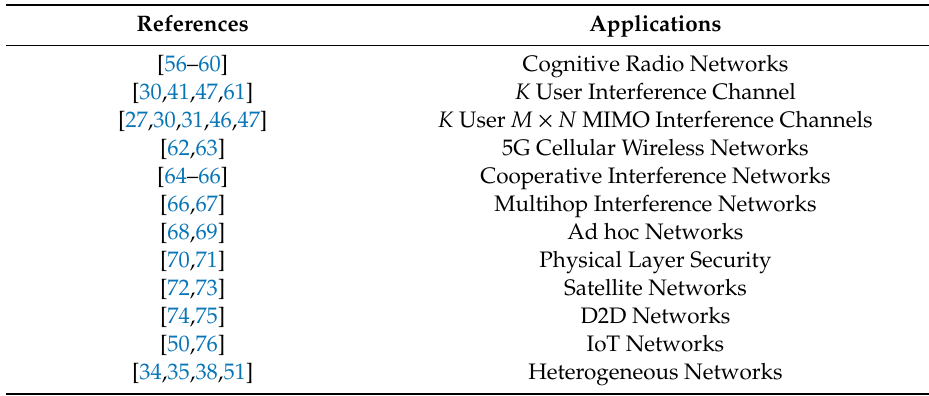
Table 3. Applications of